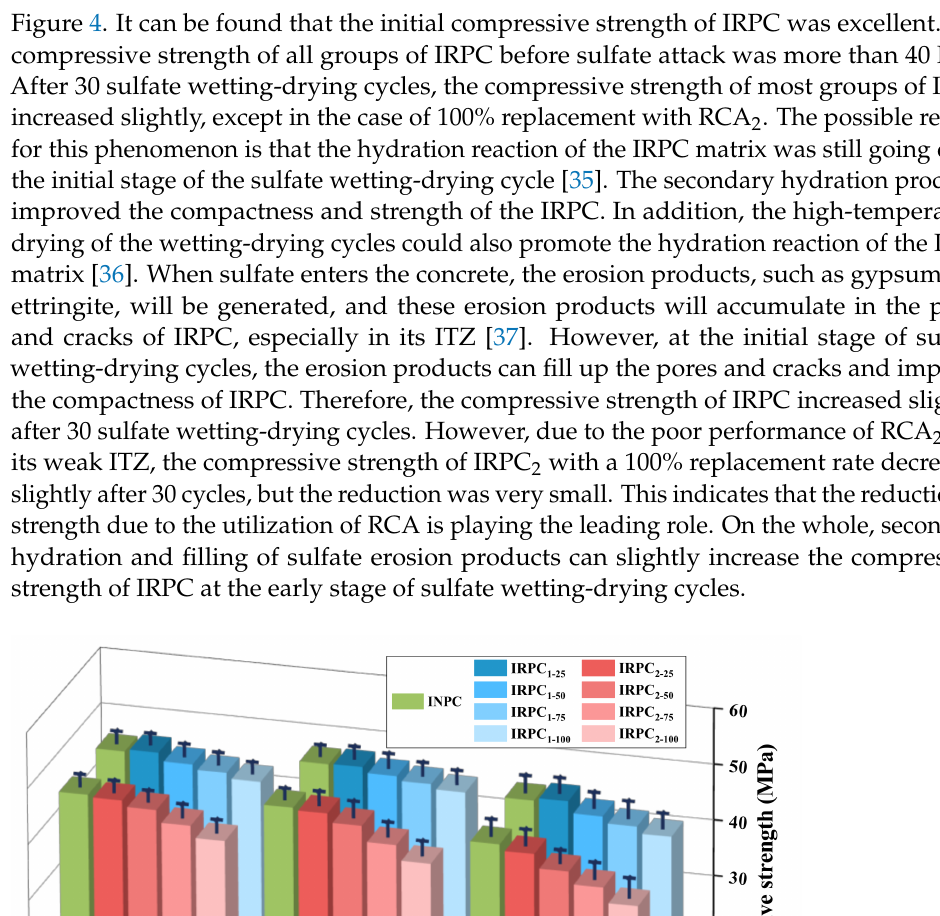
Figure 4. It can be found that the initial compressive strength of IRPC was excellent. The